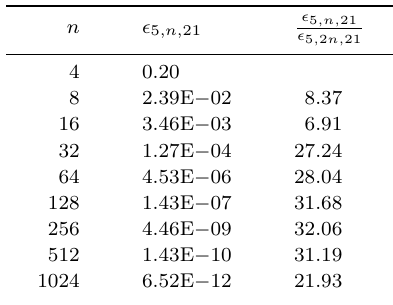
Table 3. m = 4, p = 17, λ 0 = λ 1 = 0 . 75. Table 4. m = 5, p = 21, λ 0 = λ 1 = 0 .